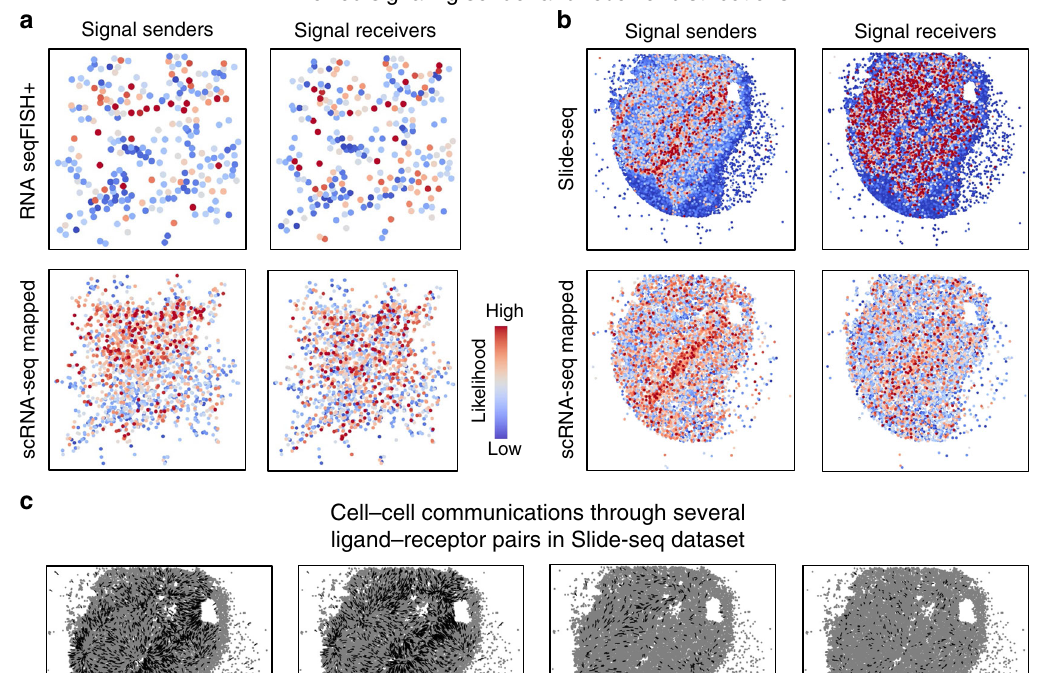
each previously identi fi ed cluster; and (3) visualization of scRNA-seq data con- One can carry out three major tasks immediately after obtaining γ * and b D sc : (1) P strained by cell – cell distances using the distance matrix b D sc . prediction of spatial gene expression at the i th position by The intercellular gene – gene regulatory information fl ow is inferred by using g 2 R n is the expression vector for a gene in scRNA-seq data; (2) identi fi cation of partial information decomposition 28,29,34 . We estimate how much unique information about a gene (target gene) can be provided by another gene (source spatially localized cell subclusters by distance-based clustering using b D sc within